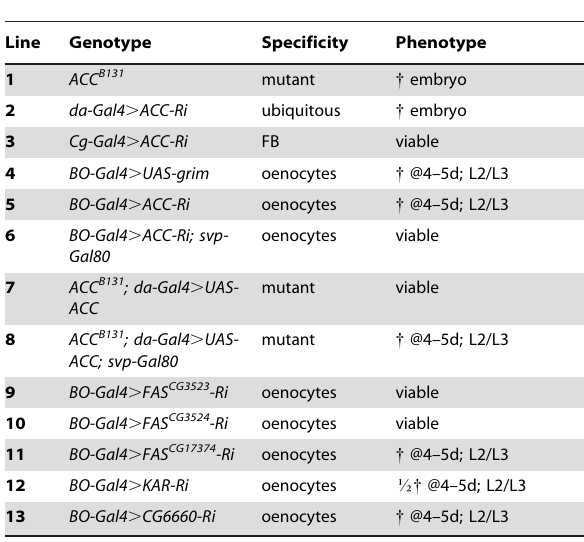
Table 1. Genetic analysis of ACC by tissue-targeted